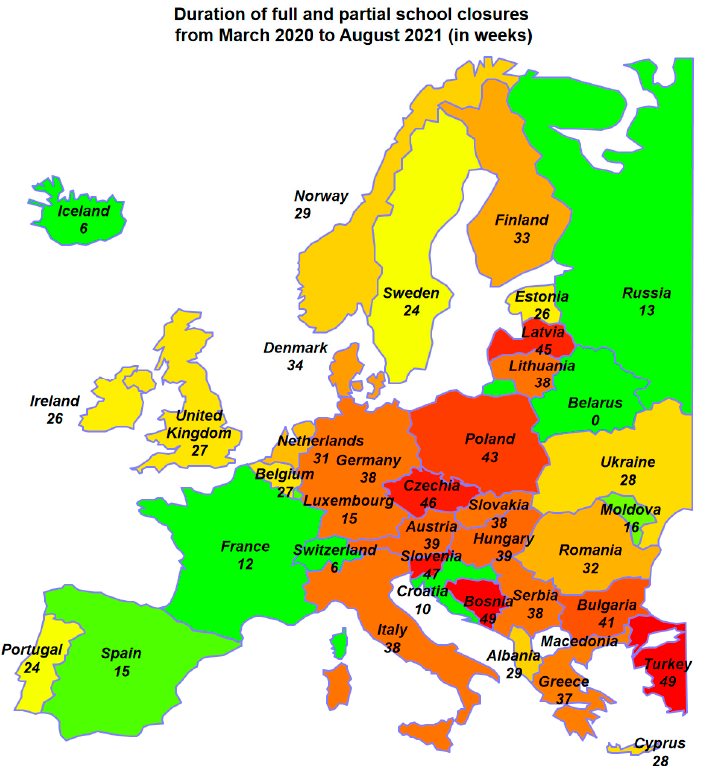
Figure 1. Duration of full and partial school closures in chosen Europe countries from March 2020 to August 2021 (Countries with a long period of school closures are marked with shades of red, and those with the shortest duration of distance learning are marked with shades of green.) [20].